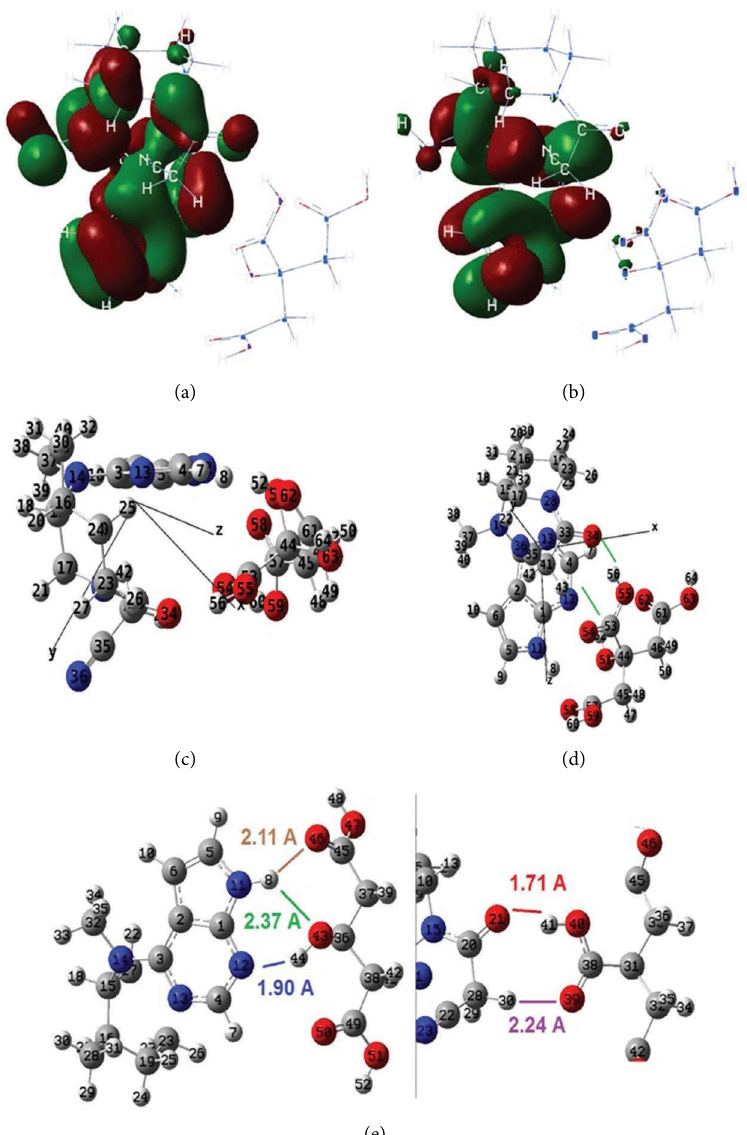
Figure 5: HOMO and LUMO (FMO) orbitals of TFC as well as the geometrical structure of the most stable state of TFC optimized at the B3LYP/6-311G(d,p) level of theory. (a) TFC HOMO. (b) TFC LUMO. (c) TFC (side view). (d) TFC (upper view). (e) TFC.